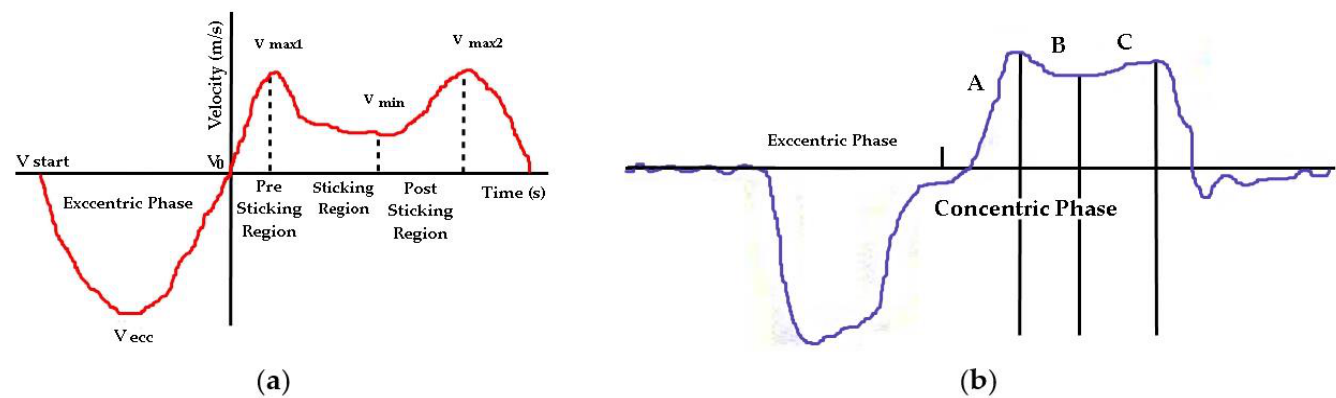
Figure 3. ( a ) Representative velocity–time curve during (sub) maximal bench press lifts (>85% of 1RM) in conventional Bench Press [21–23] and ( b ) representative velocity–time curve during (sub) maximal bench press lifts (95% of 1RM) in Paralympic Power Lifting with the different events and regions. Legend: V: velocity, V 0 : at the beginning of the concentric phase, V ecc: Velocity in the eccentric phase, Vmax1: maximum velocity at point 1, Vmax2: maximum velocity at point 2, Vmin: Minimum velocity, (m/s): Meters per second, (s): Second; A: pre-sticking period, B: sticking period; C: post-sticking period. Table 2. Mean ± SD values and 95% confidence interval (CI 95%) of velocity and time to achieve eccentric, pre-sticking, sticking, and post-sticking in Paralympic